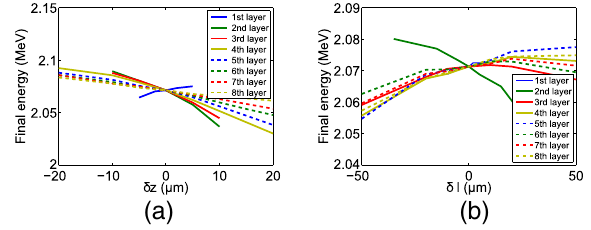
FIG. 9. Sensitivity of the multilayer gun to variations in (a) layer thicknesses and (b) length of quartz